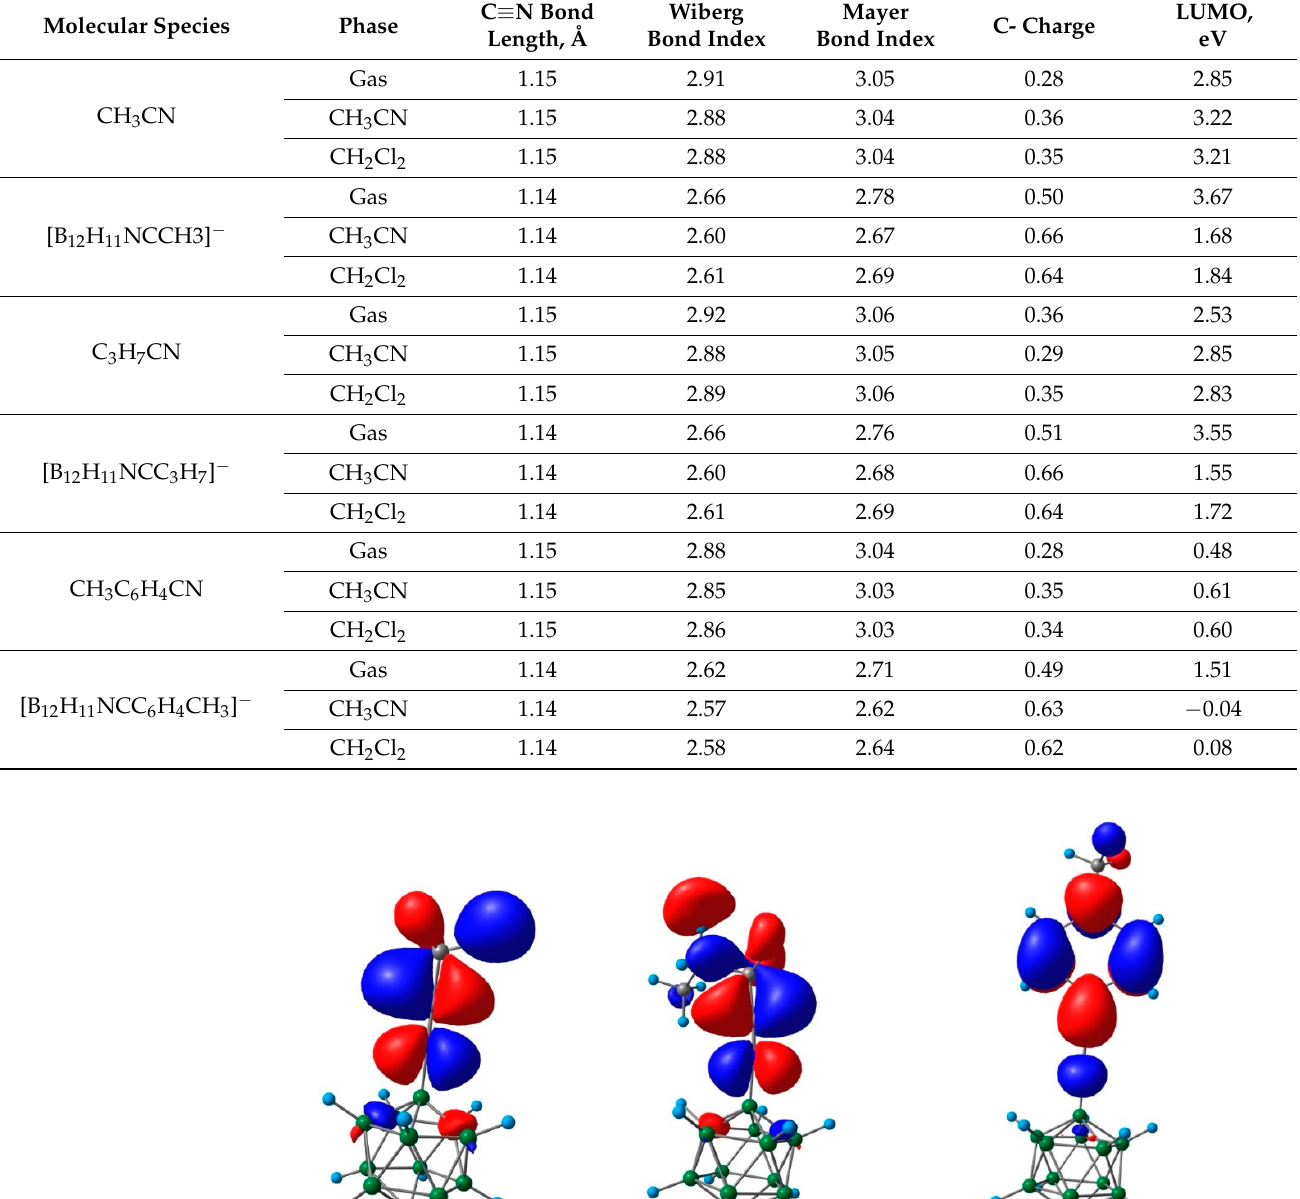
Table 1. Main considered descriptors of nitriles RCN, R = CH 3 , C 3 H 7 , CH 3 C 6 H 4 and nitrilium